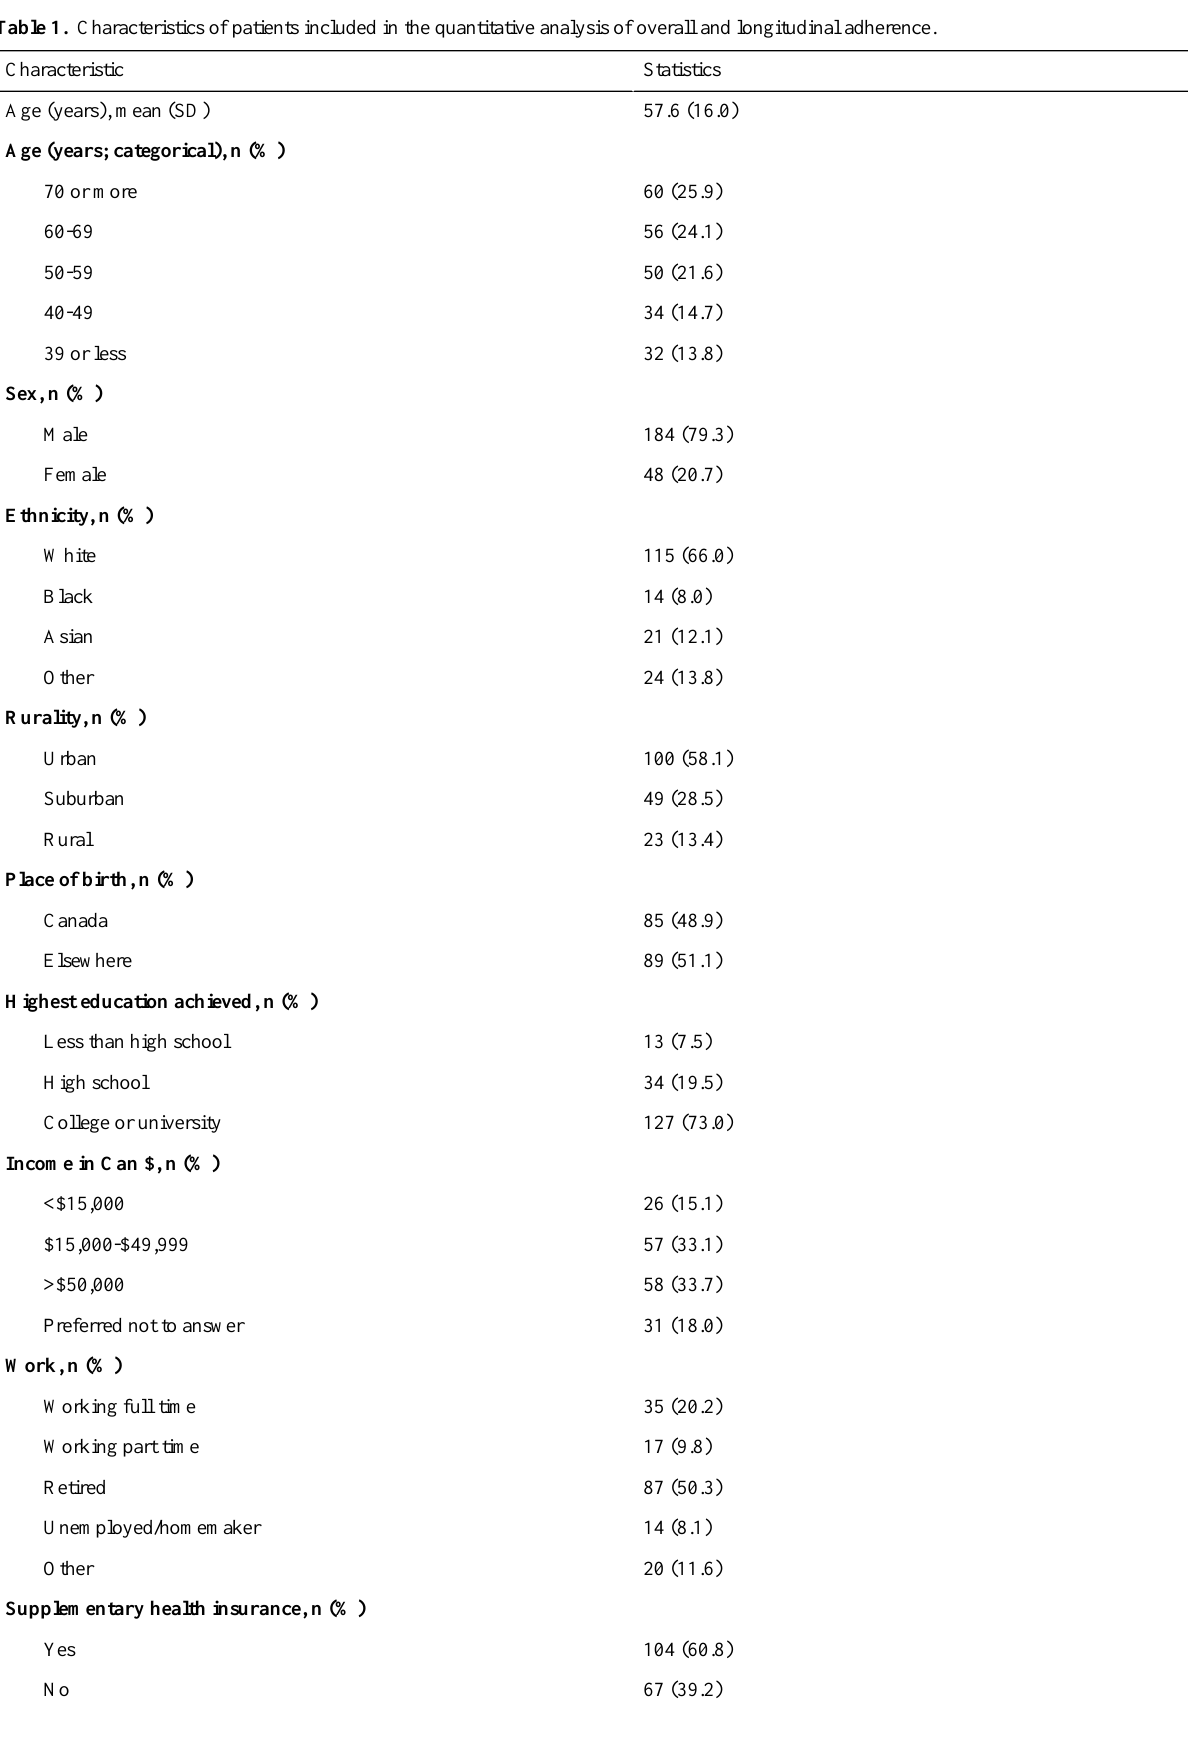
Table 1. Characteristics of patients included in the quantitative analysis of overall and longitudinal